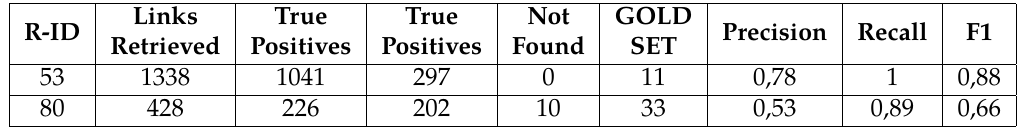
Table 6: FGTHunter results for OPENMRS